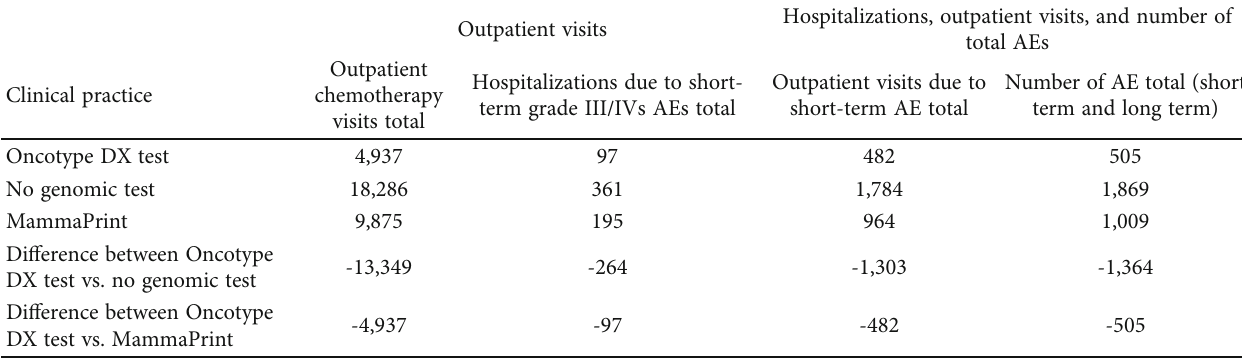
Table 4: Results presenting outpatient chemotherapy visits and data relating to AEs and hospital visits relating to